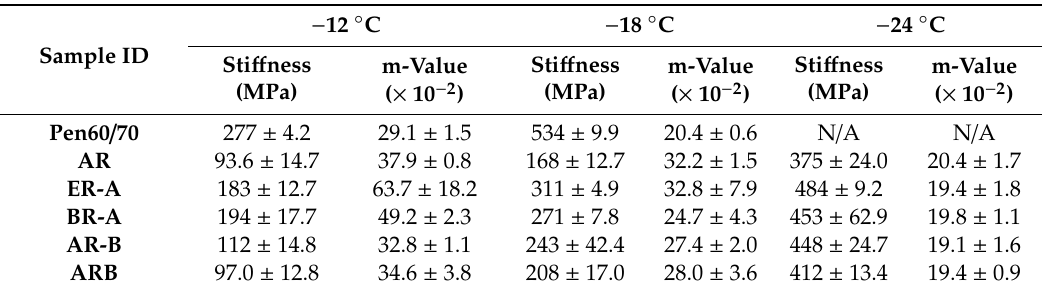
Table 3. BBR test results.